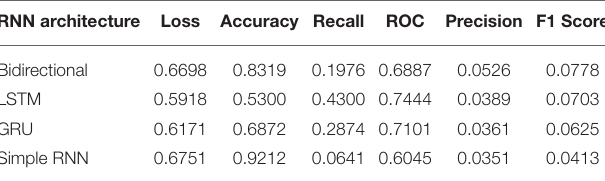
TABLE 2 | Performance metrics values of recurrent neural network (RNN) with one